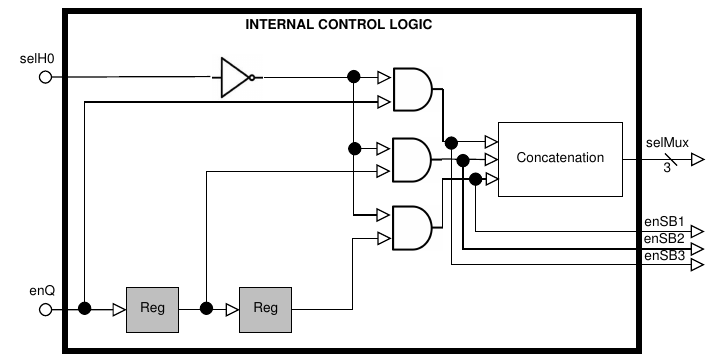
Figure 5. Block diagram of the Internal Control